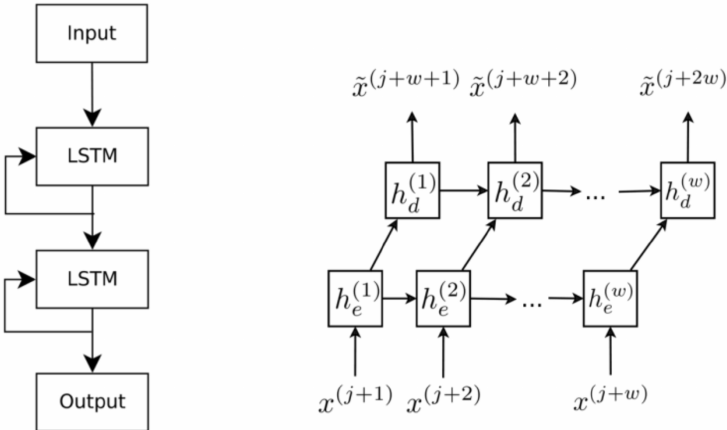
Figure 10. Neural network architecture and prediction